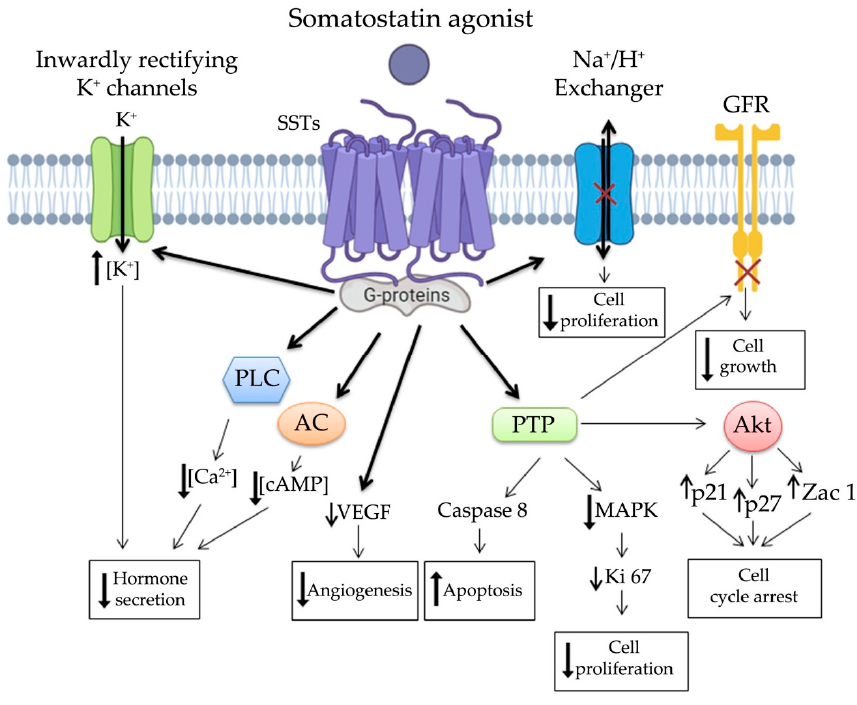
Figure 1. Simplified representation of SSTs signaling: Somatostatin and SSAs binding to SSTs activate G proteins and inhibit AC activity, inhibit Na + /H + exchanger, activate inwardly rectifying K + channels and Ca 2+ channels. These pathways modulate the antitumor activity of native somatostatin and SSAs through inhibition in secretion of several hormones and proangiogenic factors, induction of apoptosis and cell cycle arrest. GFR, growth factor receptor; PLC, phospholipase C; AC, adenylyl cyclase; cAMP, cyclic adenosine monophosphate; VEGF, vascular endothelial growth factor; PTP, phosphotyrosine phosphatase; MAPK, mitogen-activated protein kinase and Akt protein kinase B.